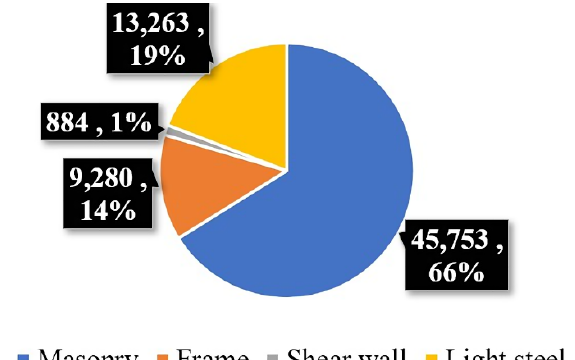
Figure 22. Ratios of structural type in Daxing downtown.